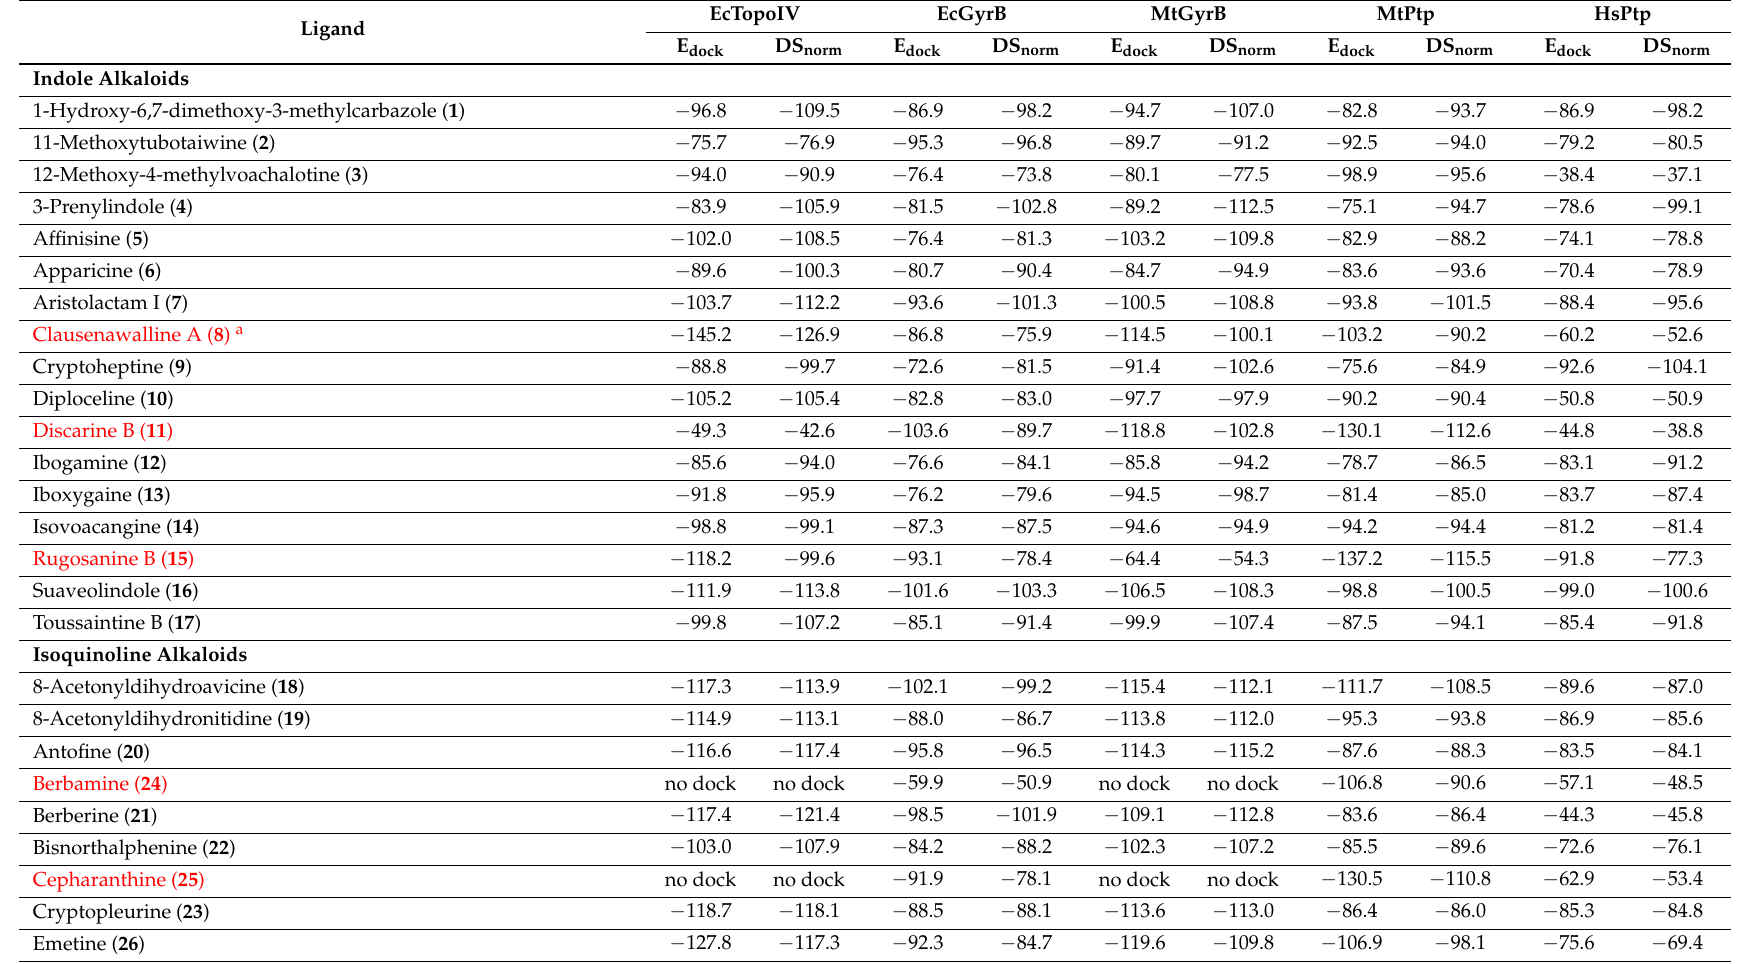
Table 3. MolDock molecular docking energies (E dock , kJ/mol) and normalized docking scores (DS norm ) for antibacterial phytochemical ligands with bacterial topoisomerases and bacterial protein tyrosine